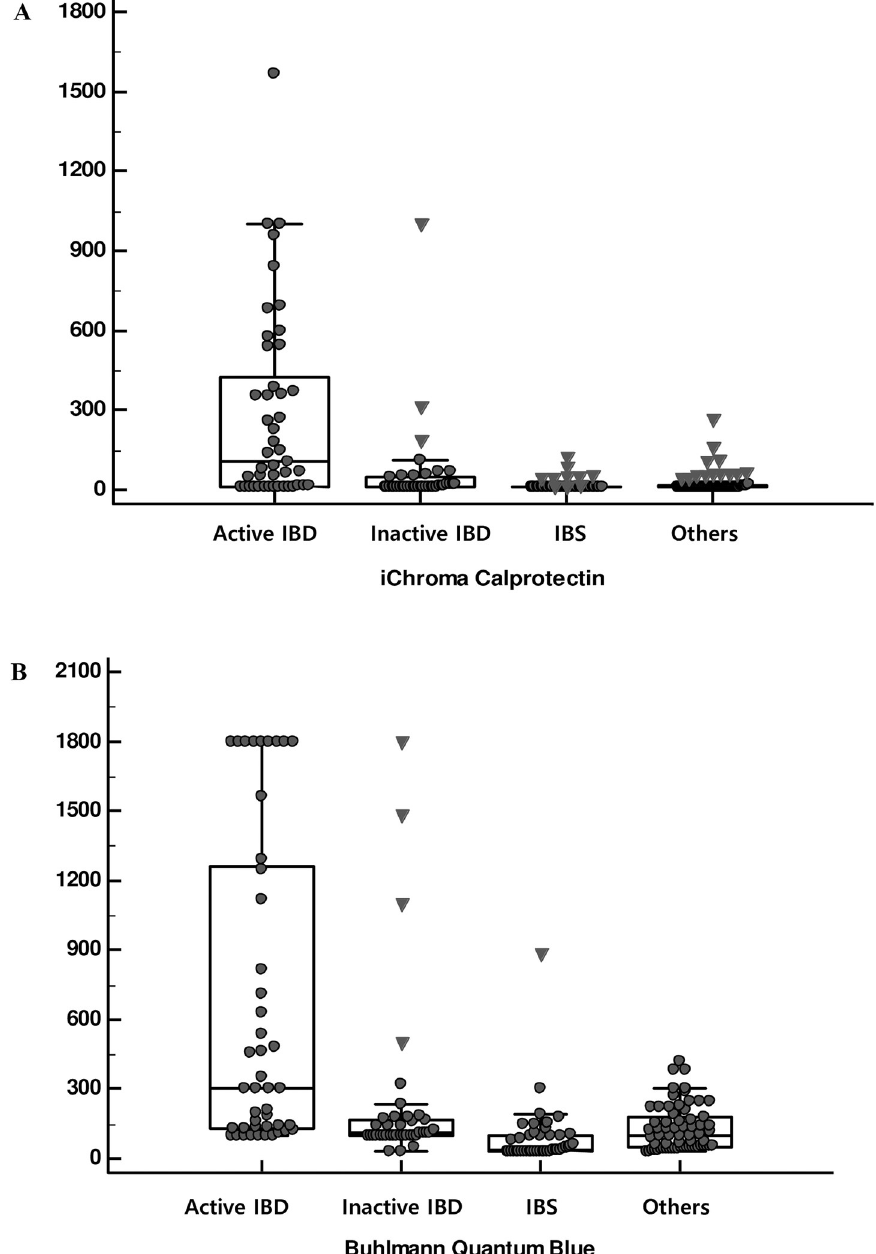
Fig 1. Fecal calprotectin levels by the two rapid tests according to the disease status. (A) iChroma calprotectin tests, (B) Buhlmann Quantum Blue tests.